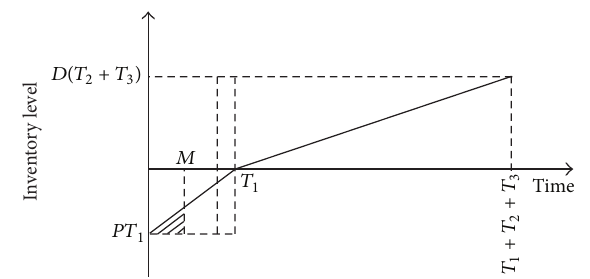
Figure 2: The total accumulation of interest earned when 𝑀 ≤ 𝑇 1 .